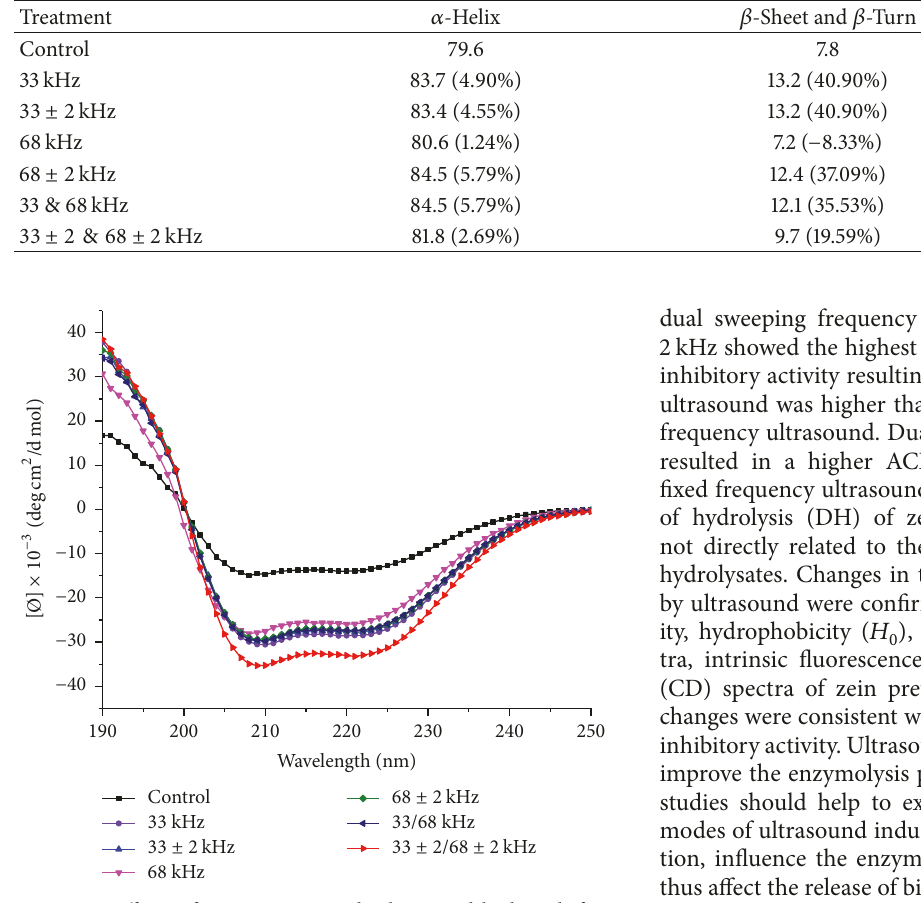
Figure 7: Effects of pretreatment with ultrasound bath with four different working modes and two frequencies on the circular dichroism spectra of